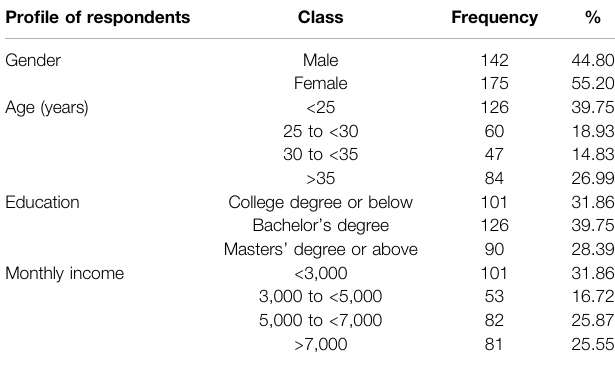
TABLE 1 | Description of the sample ( N (cid:1)